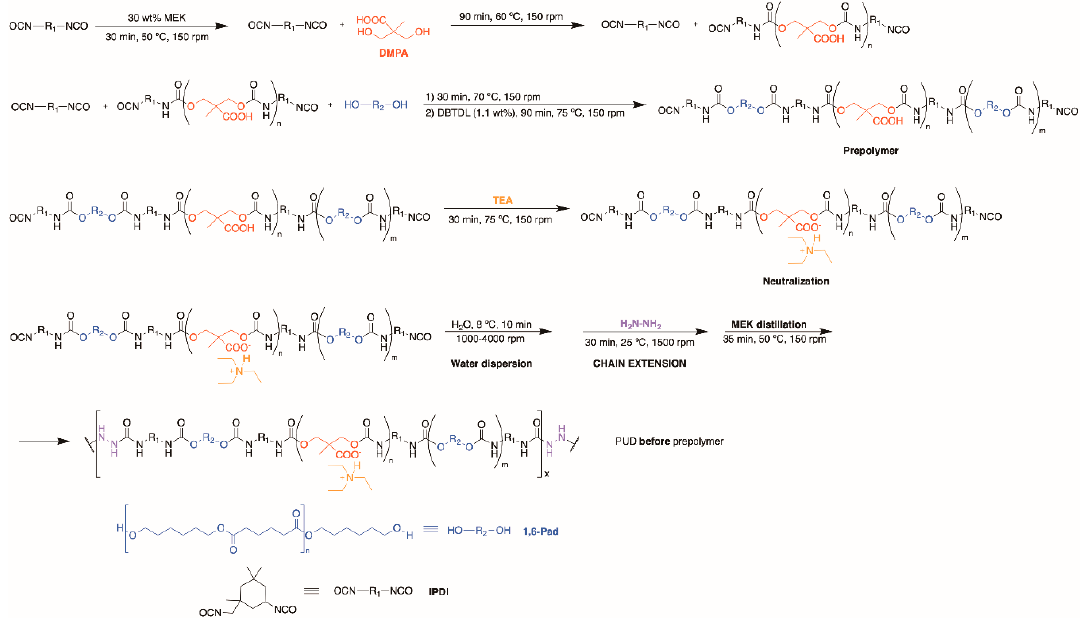
Figure 1. Scheme of the synthesis of the poly(urethane-urea) (PUD) by adding dimethylolpropionic acid (DMPA) before prepolymer formation.